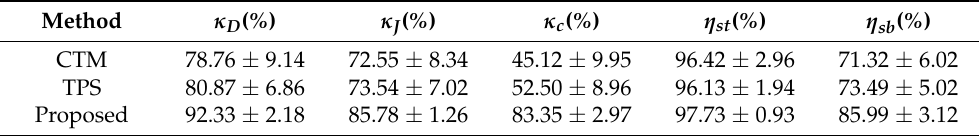
Table 2. Quantitative performance analyses of the rat brain extraction methods applied to the TTC-stained image dataset.